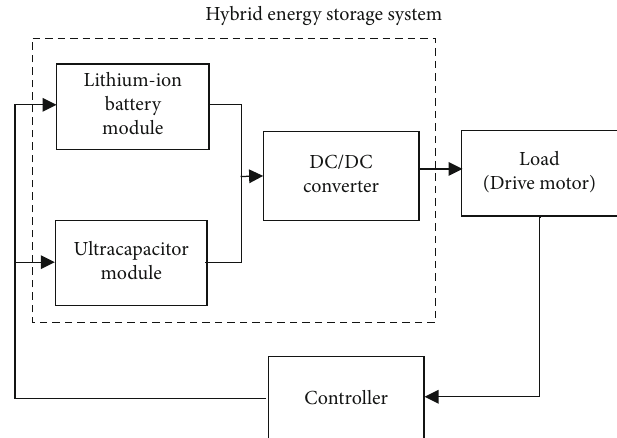
Figure 3: A basic EV HESS model.